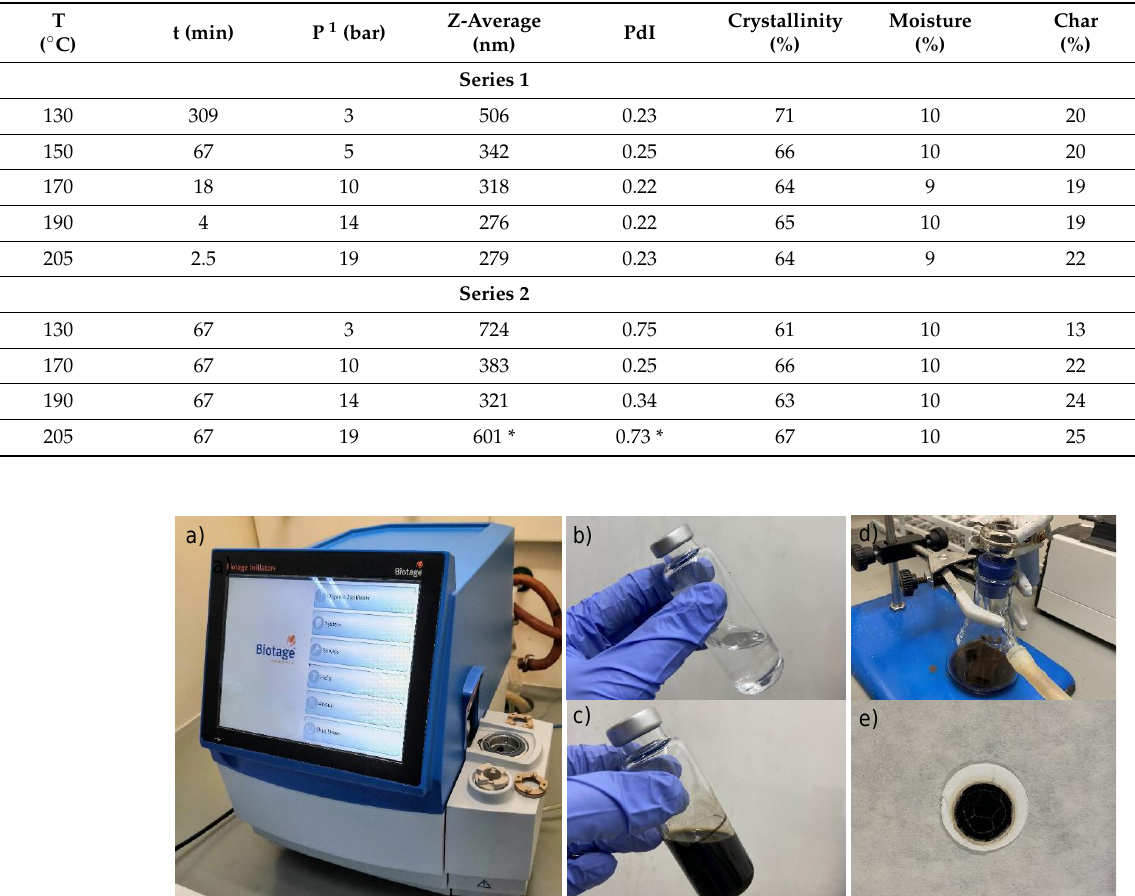
Table 1. Experimental conditions used for the synthesis of NH 4 CN polymers assisted by MW radiation, as well as some of their properties. Note that polymer 2 is present in both series. 1 Maximum pressure reached along the syntheses. * No reproducible measurements.